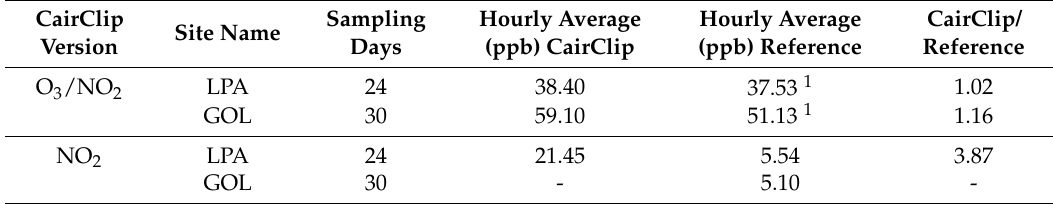
Table 2. Measurements at the reference